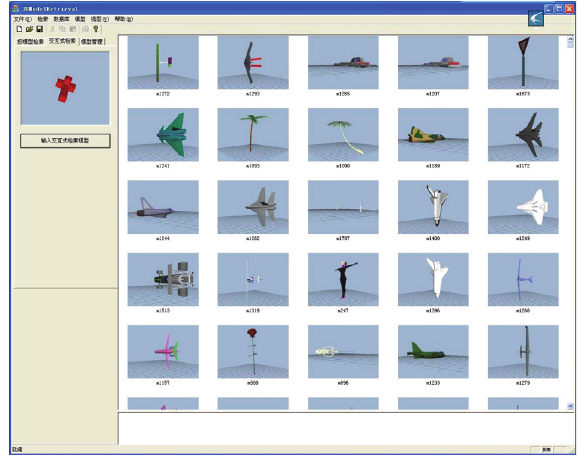
Figure 9: The plane model experimental result.